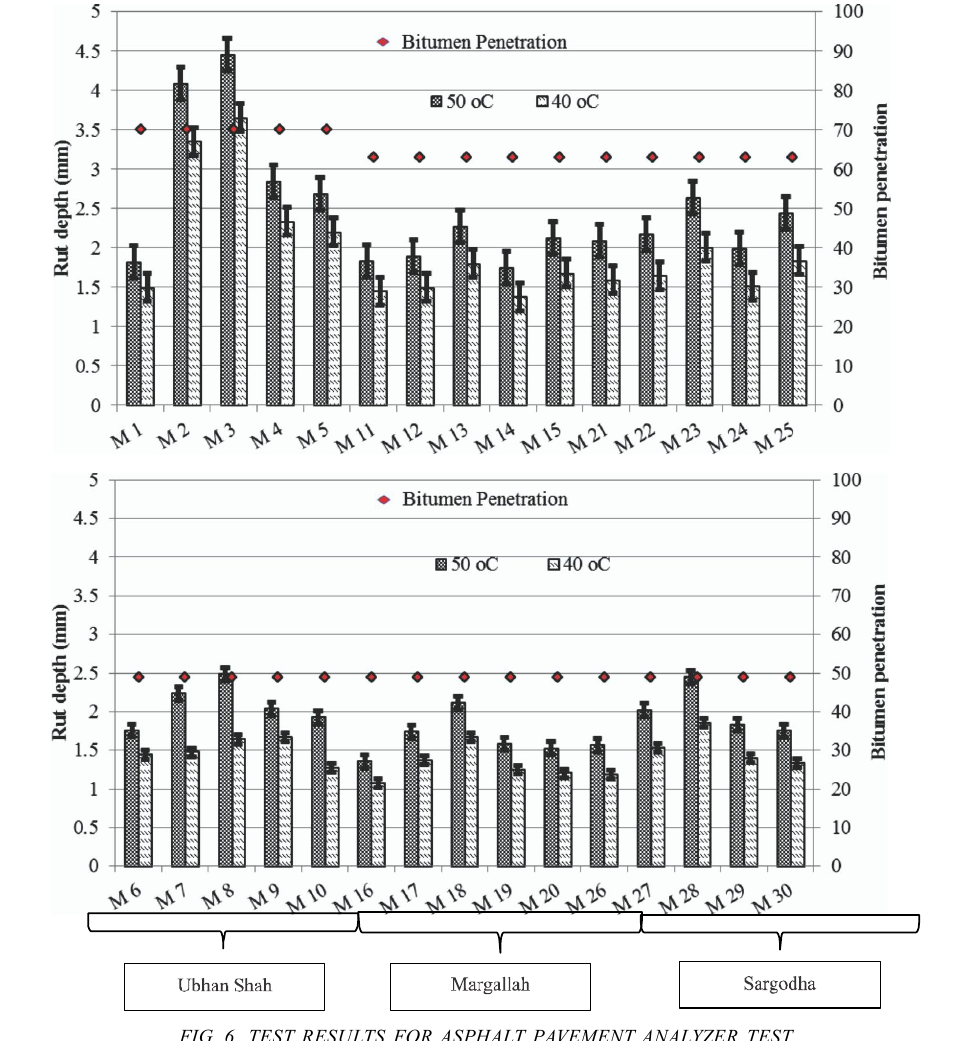
FIG. 6. TEST RESULTS FOR ASPHALT PAVEMENT ANALYZER